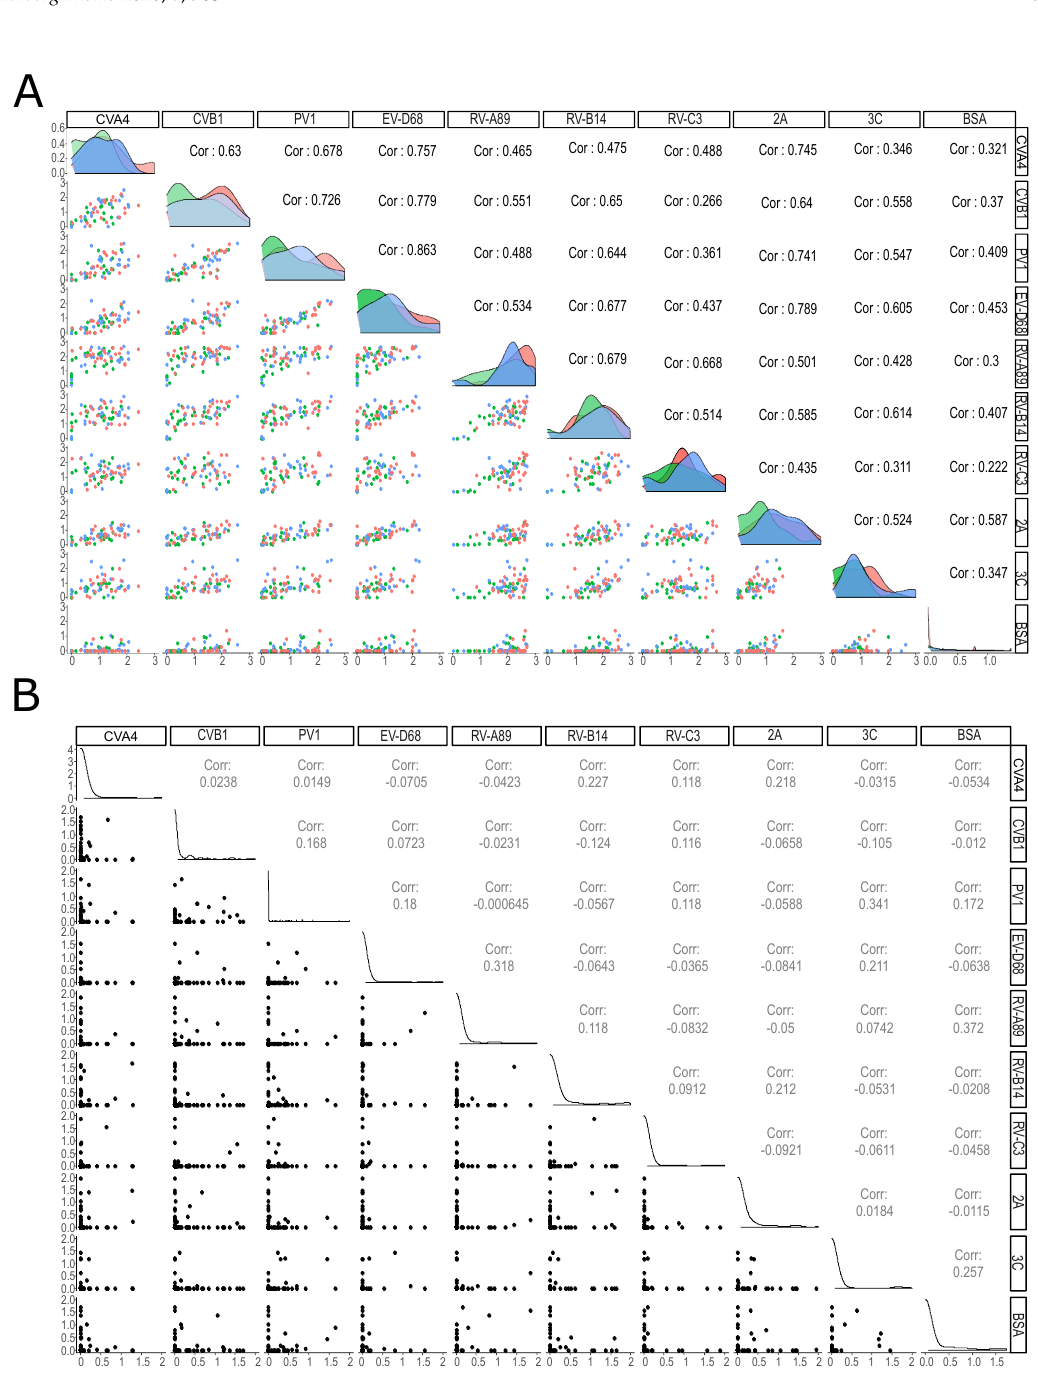
Figure 4. Scatterplots and correlations of antibody responses between di ff erent enterovirus antigens. The lower diagonal has scatterplots showing how pairs of antibody responses are correlated in ( A ) adults and ( B ) children and in the upper diagonal shows the corresponding Spearman correlation coe ffi cients. In panel A, the diagonal shows the distribution of antibody responses grouped by IgM status: blue represents IgM positive group, green the IgM negative group and red the Tampere biobank samples collected from healthy adults, for which we do not know the IgM status, and which are representing the population